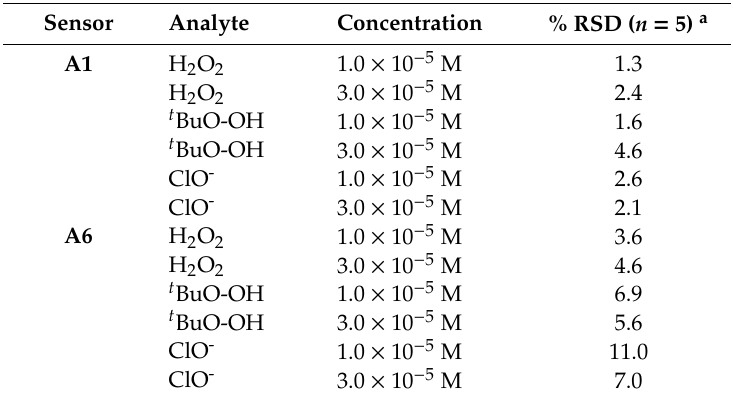
a RSD: Relative standard deviation for five